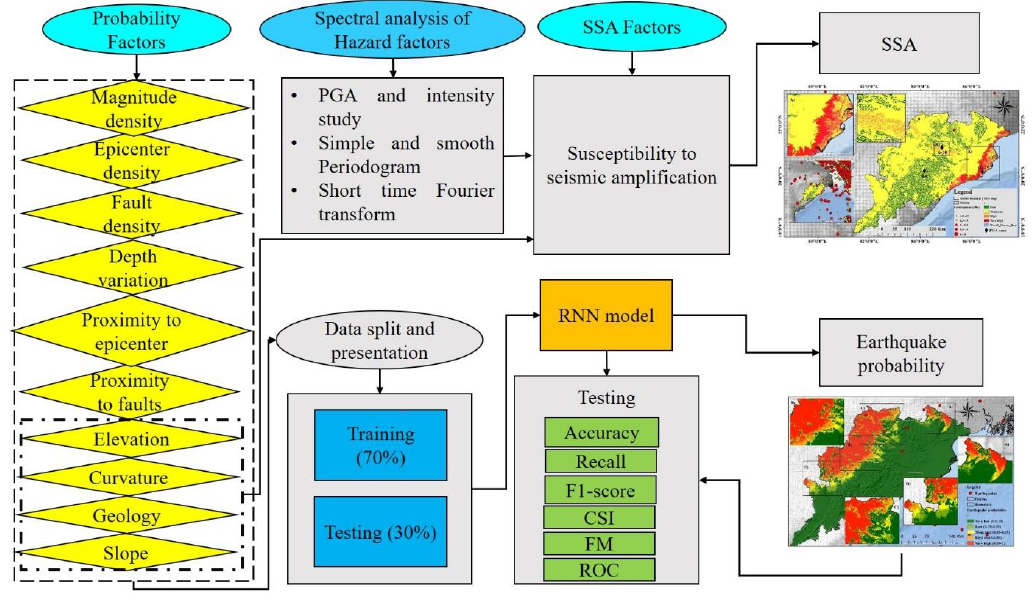
Figure 4. Overall methodological flowchart.